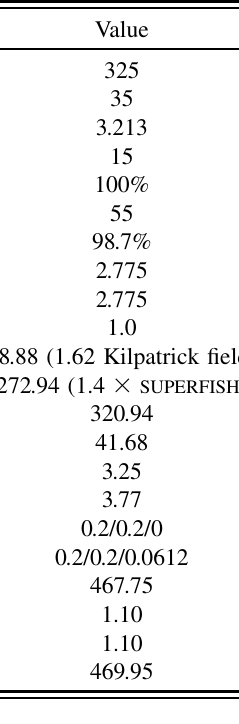
TABLE II. Main design parameters for the Injector Scheme-I